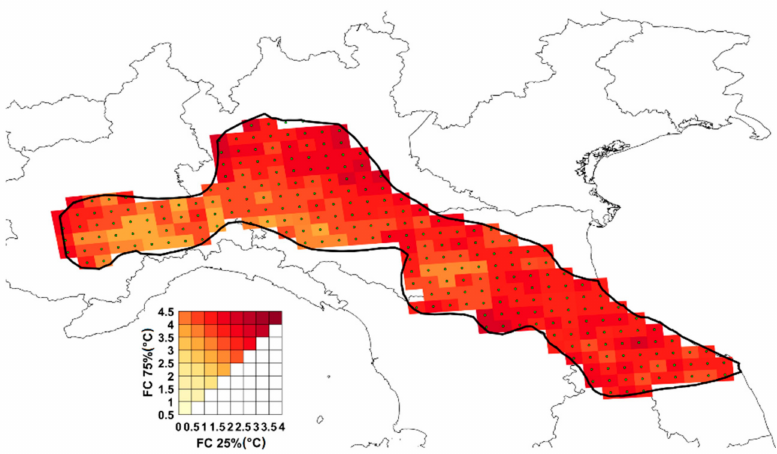
Figure 3. Example of bivariate factor of change map for T Max,k .